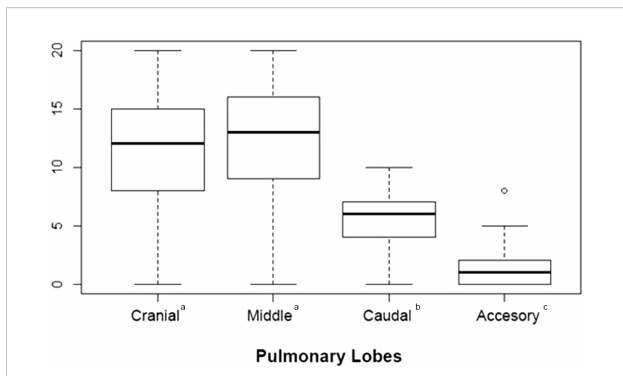
FIGURE 2 Distribution of pulmonary lesions scores in fattening pigs in a Colombian slaughterhouse according to the Goodwin scale ( n = 1,161). a,b,c Different lower-case superscripts indicate statistically signi fi cant differences ( p ≤ 0.001). The differences were obtained by the Spearman